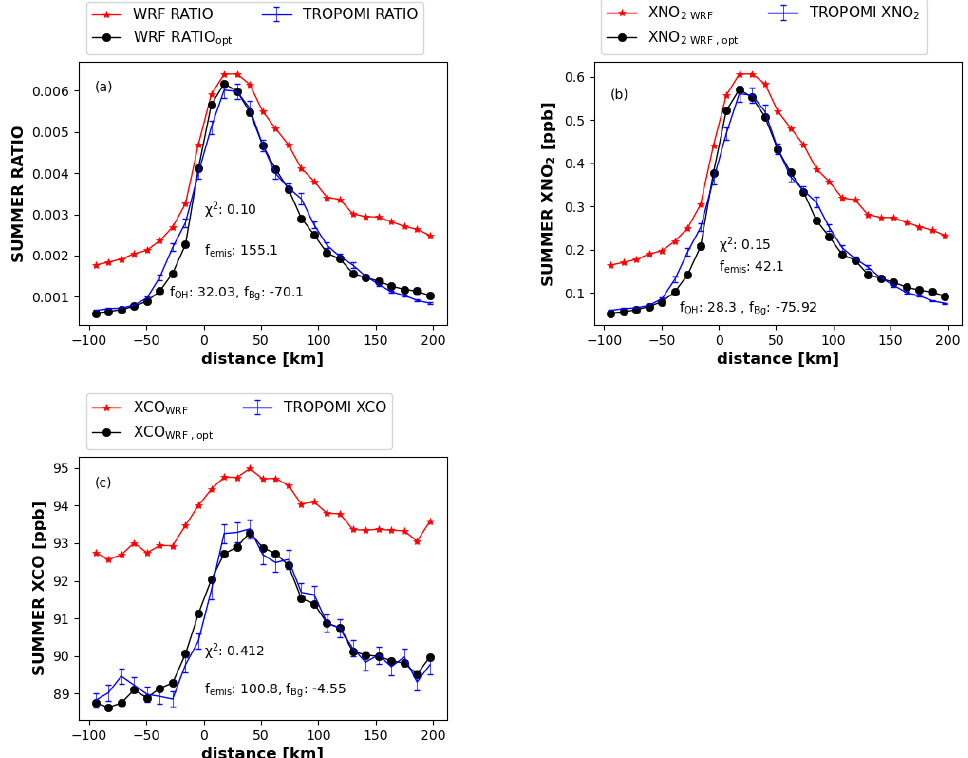
Figure 4. Comparison between TROPOMI and WRF, before and after optimization for summer (averaged over June to October 2018) (a) XNO 2 / XCO ratio, (b) XNO 2 and (c) XCO in comparison to TROPOMI; f OH , f emis and f Bg are optimized scaling factors obtained iteratively for OH, emissions and background by the least-squares optimization method; f emis , f OH and f Bg are derived by accounting the total change in emission, OH and background using the corresponding scaling factors obtained from the first and second iterative steps. The unit of the scaling factor is in percent (%). Table 2. Overview of WRF-optimized OH and NO x emissions for Riyadh and comparison to the EMG method. The estimated uncertainty for EMG- and WRF-derived NO x emissions and OH concentrations is the sum of the contribution of wind speed, length and width of the box, NO 2 bias correction, CO bias, and the different pathways of NO x loss provided in Tables S1, S2 and S3. Parameter Summer WRF optimization Summer EMG Winter WRF optimization Winter EMG Prior Optimized Prior